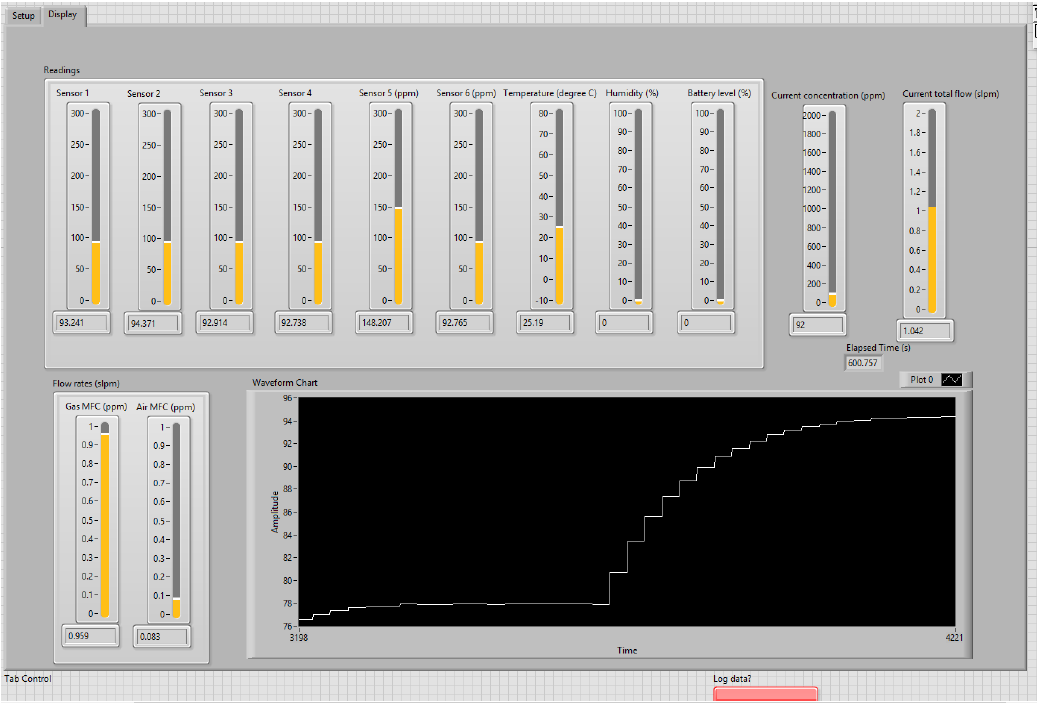
Figure 5. Graphical User Interface (GUI) displaying the measurements of CO gas for calibration.